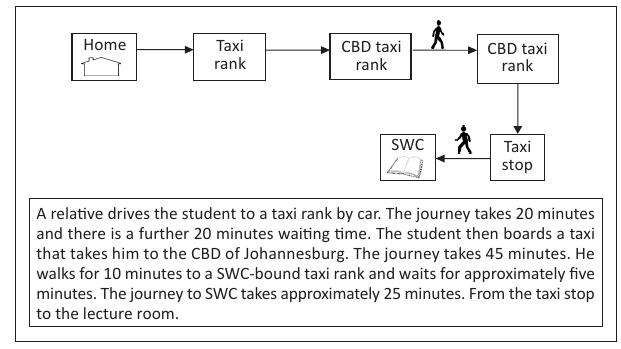
FIGURE 8: Travel pattern of a Soweto based student.